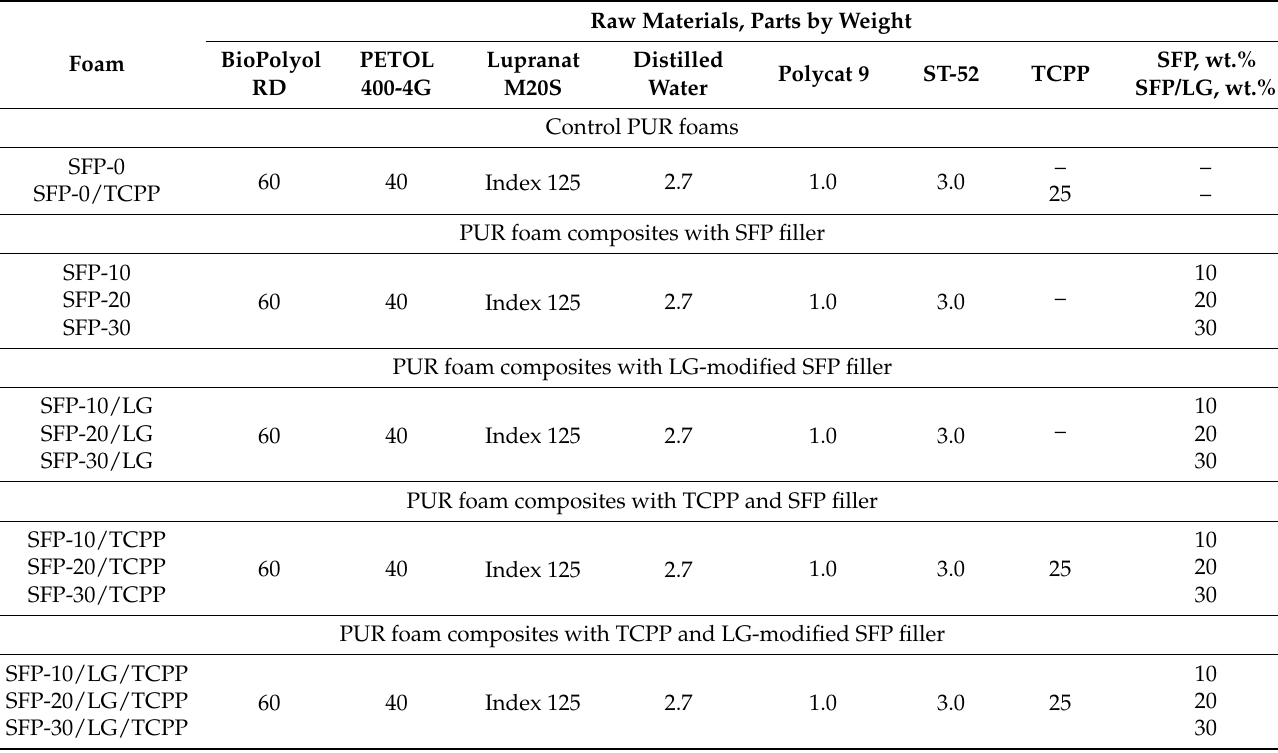
Table 1. Compositions of PUR foam composites with and without flame